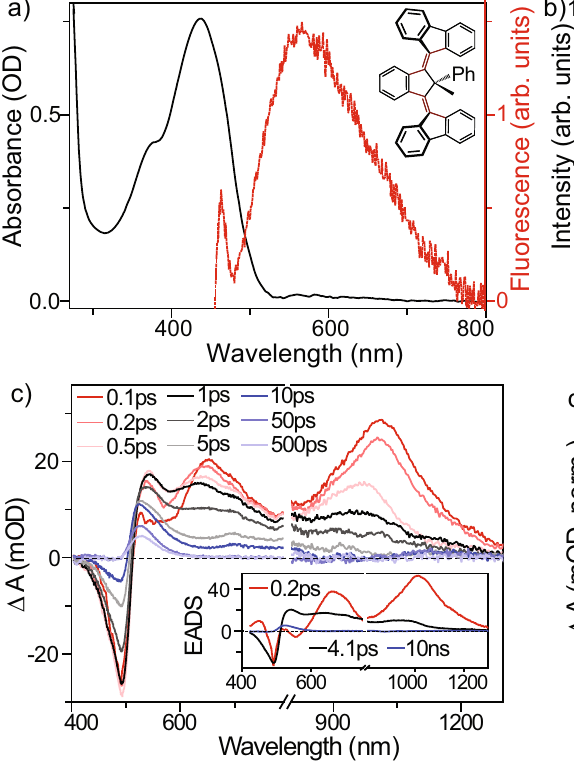
showing spectral evolution in excited 3GMph; spectra were measured in two spectral windows and stitched together at ca 800nm. Inset: components of the transient absorption data recovered from global analysis assuming a simple sequential kinetic model with a single intermediate state to yield three evolution- associated difference spectra (EADS); d Population dynamics at four different wavelengths (circles) with quality of fi t of the sequential global analysis model shown (solid